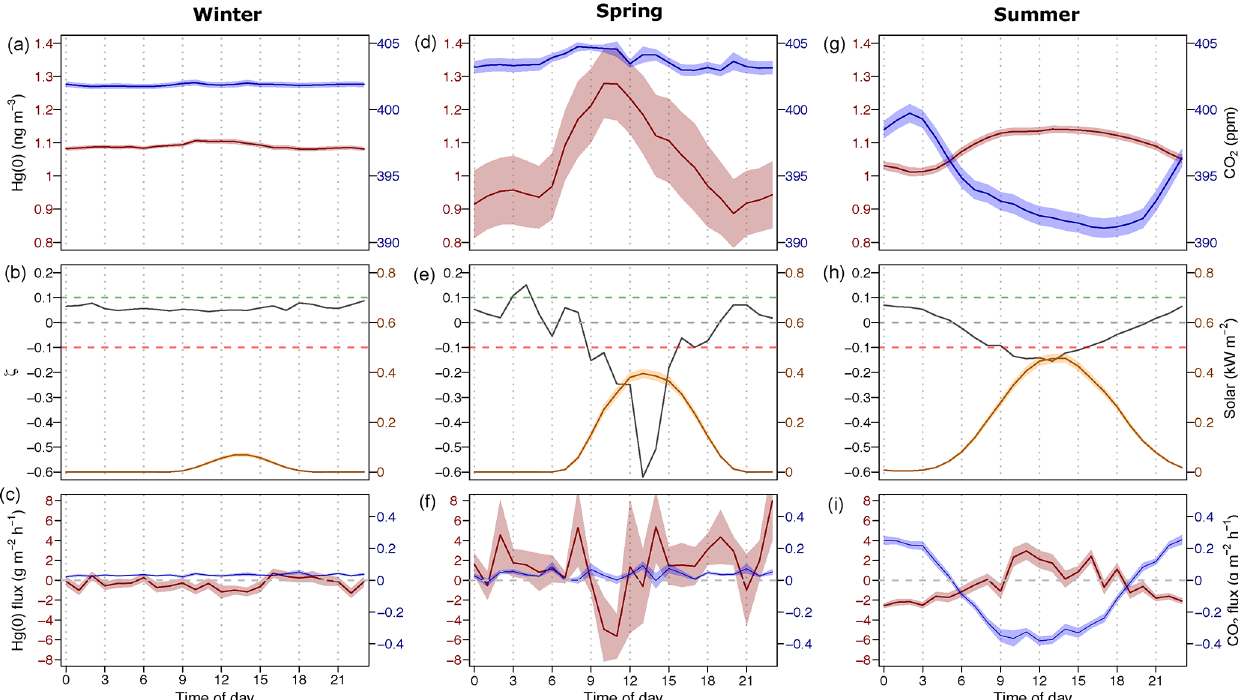
Figure 1. Diel variation during winter (a, b, c) , spring (d, e, f) , and summer (g, h, i) : (a, d, g) average Hg(0) concentration (in red) and the CO 2 mixing ratio (in blue) in the atmosphere (2m height). (b, e, h) The median planetary boundary layer stability parameter ( ζ , grey), where positive values represent stable conditions, and solar radiation is shown in yellow. (c, f, i) The average Hg(0) flux (in red) and the average CO 2 flux (in blue). The shaded areas in (a) and (c) represent the mean ± 1SD interval of concentration and flux measurements, respectively.